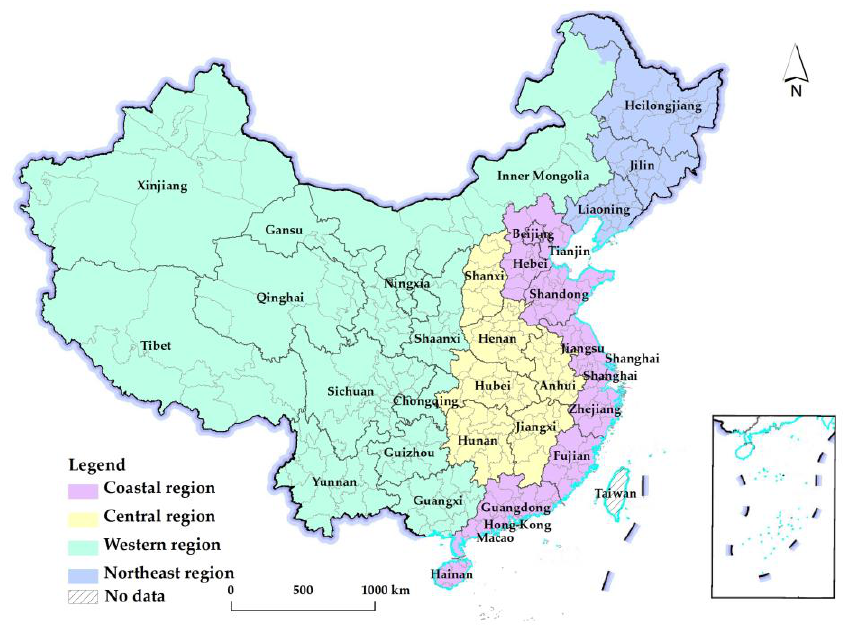
Figure 2. The research samples in this study.